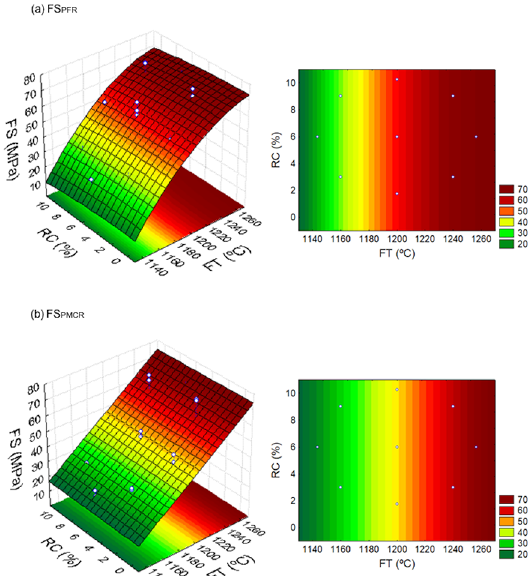
Figure 6. Response surface of the variable FS, for the compositions: (a) PFR and (b)